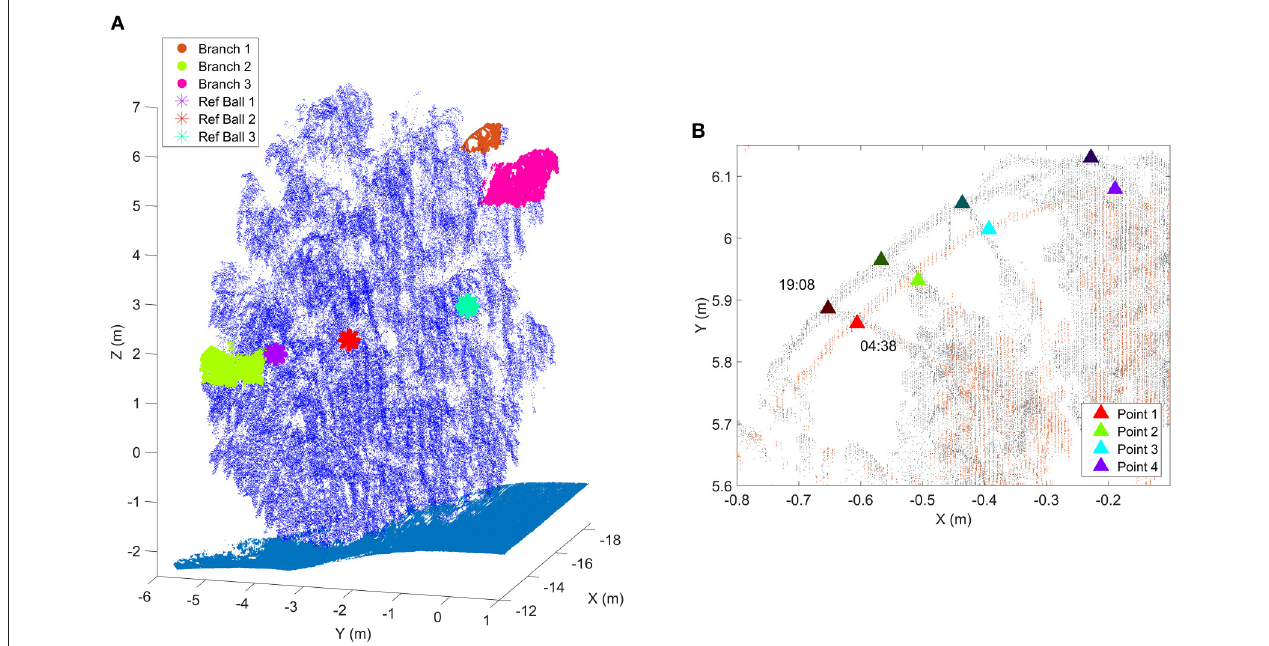
FIGURE 2 | (A) The birch at the Austrian test site. The selected target branches and the three detected reference markers have specific coloring. Ground points are presented with cyan. Reference target sizes have been emphasized in the figure for visualization purposes. The scanner was located in the origin (0,0,0). (B) A close-up of Branch 1 at two different times. Triangles represent the manually selected representative points of which total 3D movements were followed over time. Dark triangles represent the initial point locations at sunset (19:08), bright triangles the corresponding point locations at the time of the movement maximum (04:38).